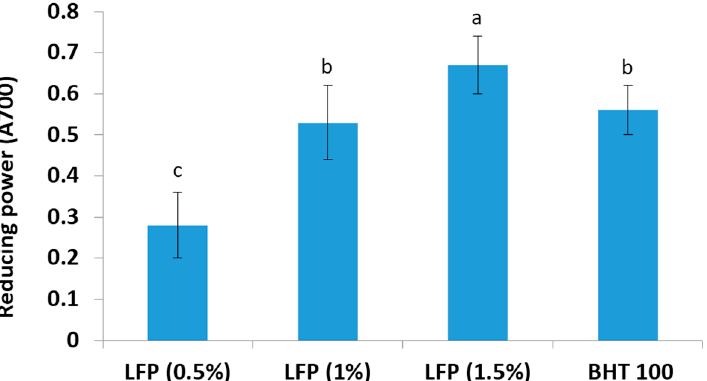
Figure 3. Ferric reducing antioxidant power of litchi fruit pericarp extracts (0.5%, 1.0% and 1.5%) and BHT (100 ppm). Meat values bearing different superscripts (a, b and c) differ significantly ( p < 0.05).